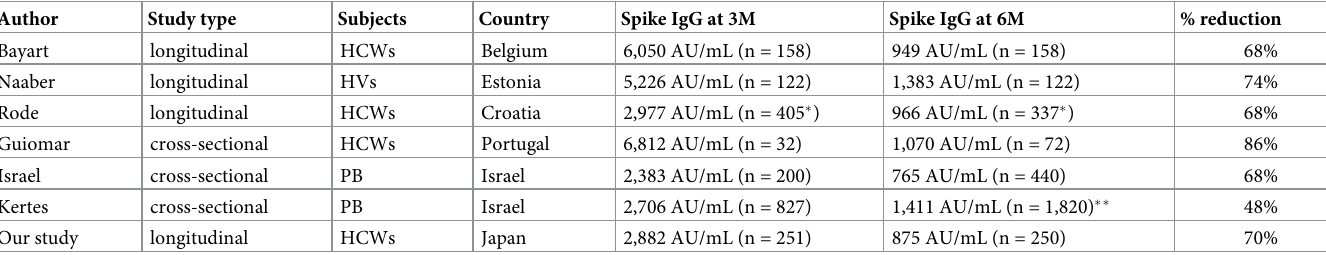
Table 6. Reported spike IgG levels at 3 months and 6 months after two doses of BNT162b2